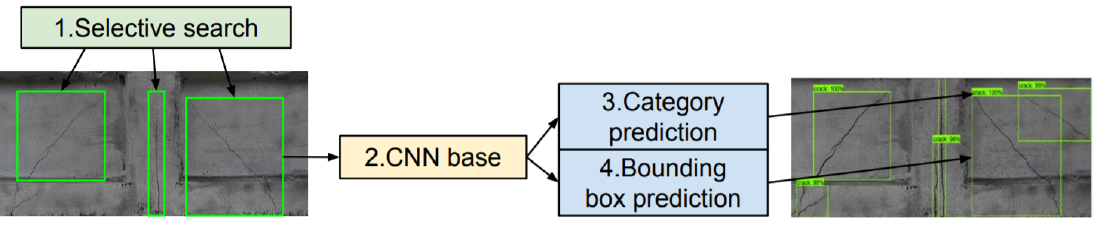
Figure 2. Diagram of the R-CNN model